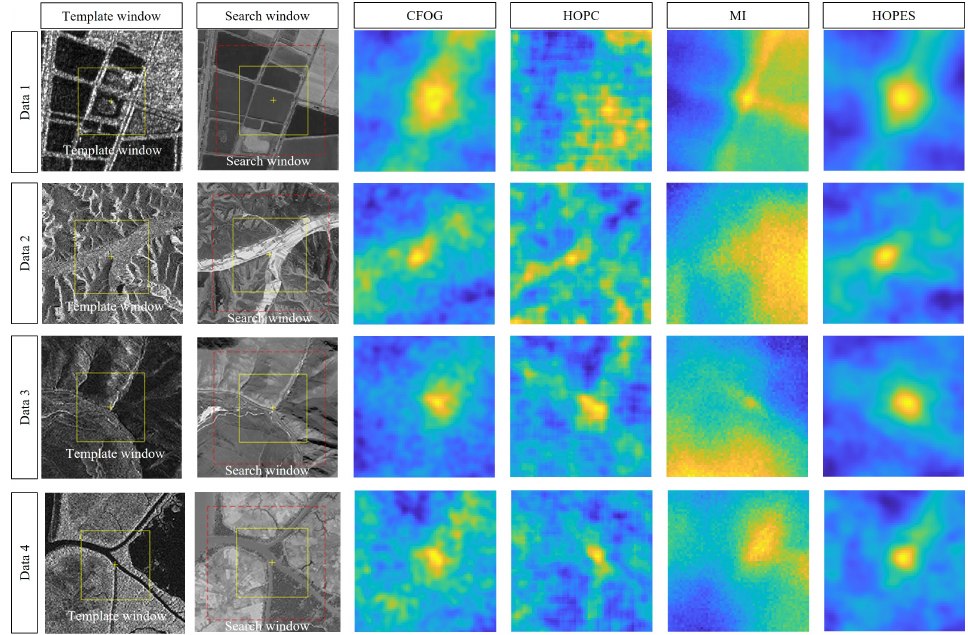
Figure 15. Similarity measure maps of CFOG, HOPC, MI, and HOPES for the SAR and optical image